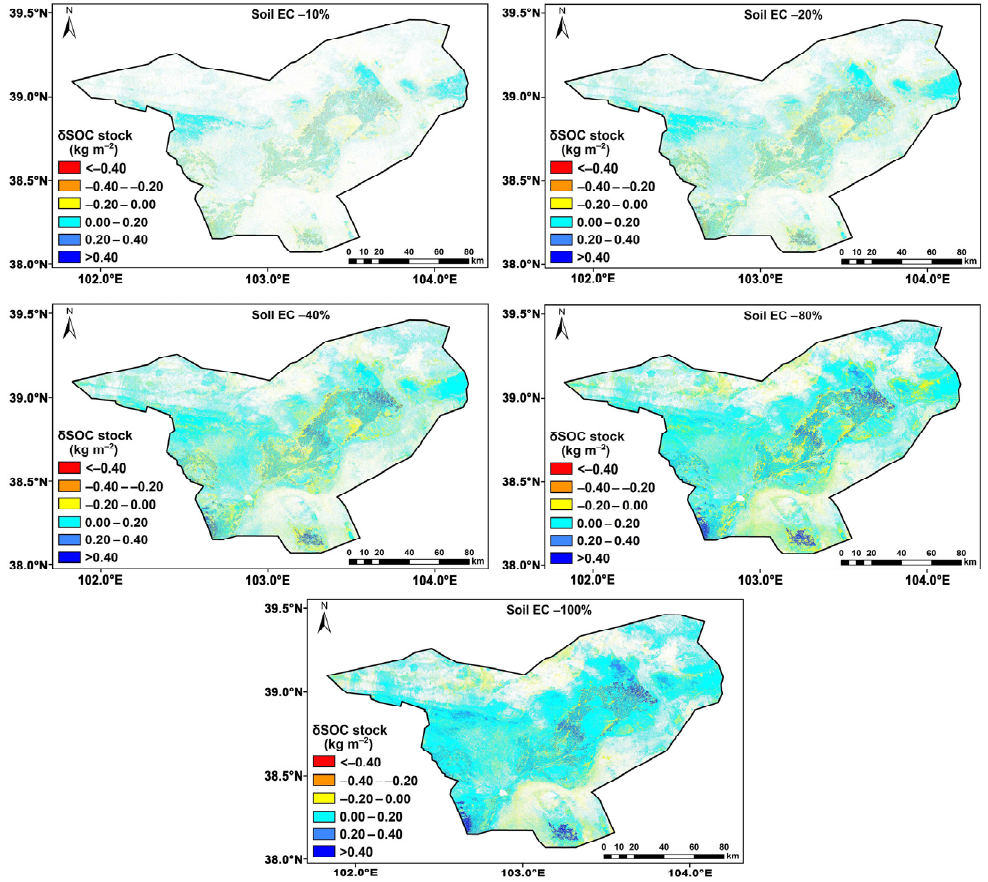
Figure 10. Spatial distribution of δ SOC stock (differences between the scenario and baseline) derived from 30 runs of the XGBoost models under different salinity decrease scenarios. Note: ‘EC –’ indicates decreased soil salinity.